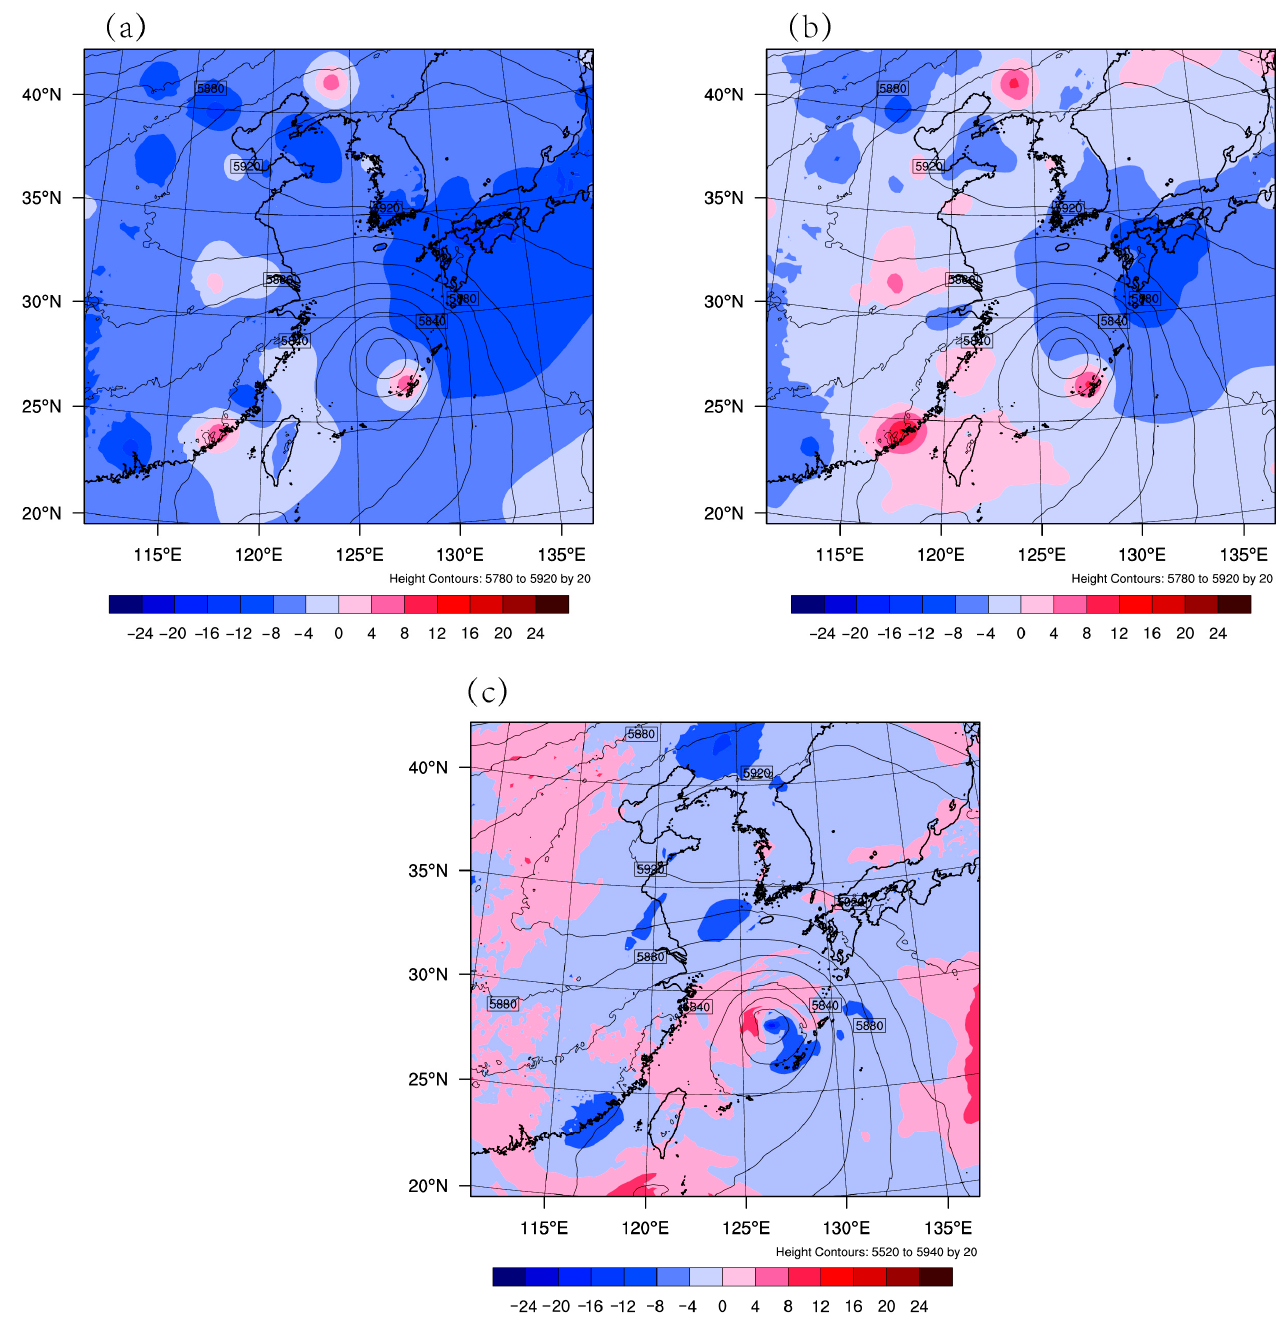
Figure 8. 500 hPa geopotential height increment (unit: gpm) of ( a ) the CONV experiment, ( b ) the 3DVar experiment, and ( c ) the EnVar experiment at 0600 UTC on 21 July 2018.